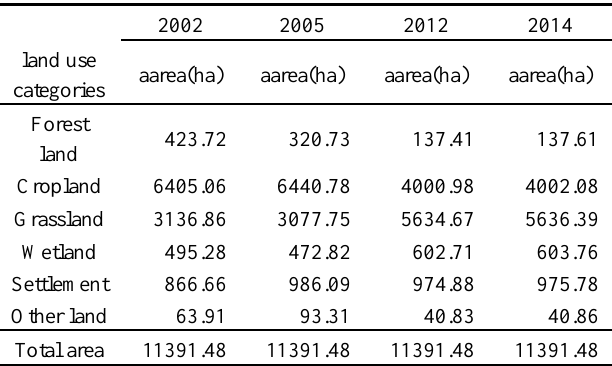
Figure 3. Land use changing during 2002-2014 in study